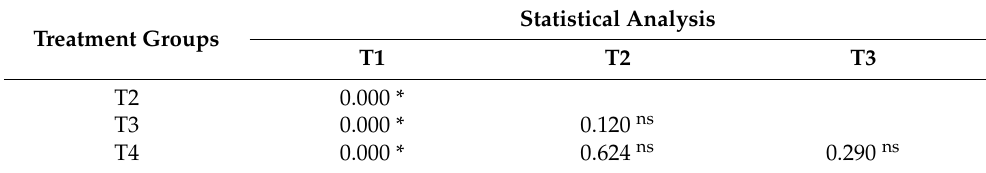
Table 3. Statistical significance among dietary treatment groups using a log-rank